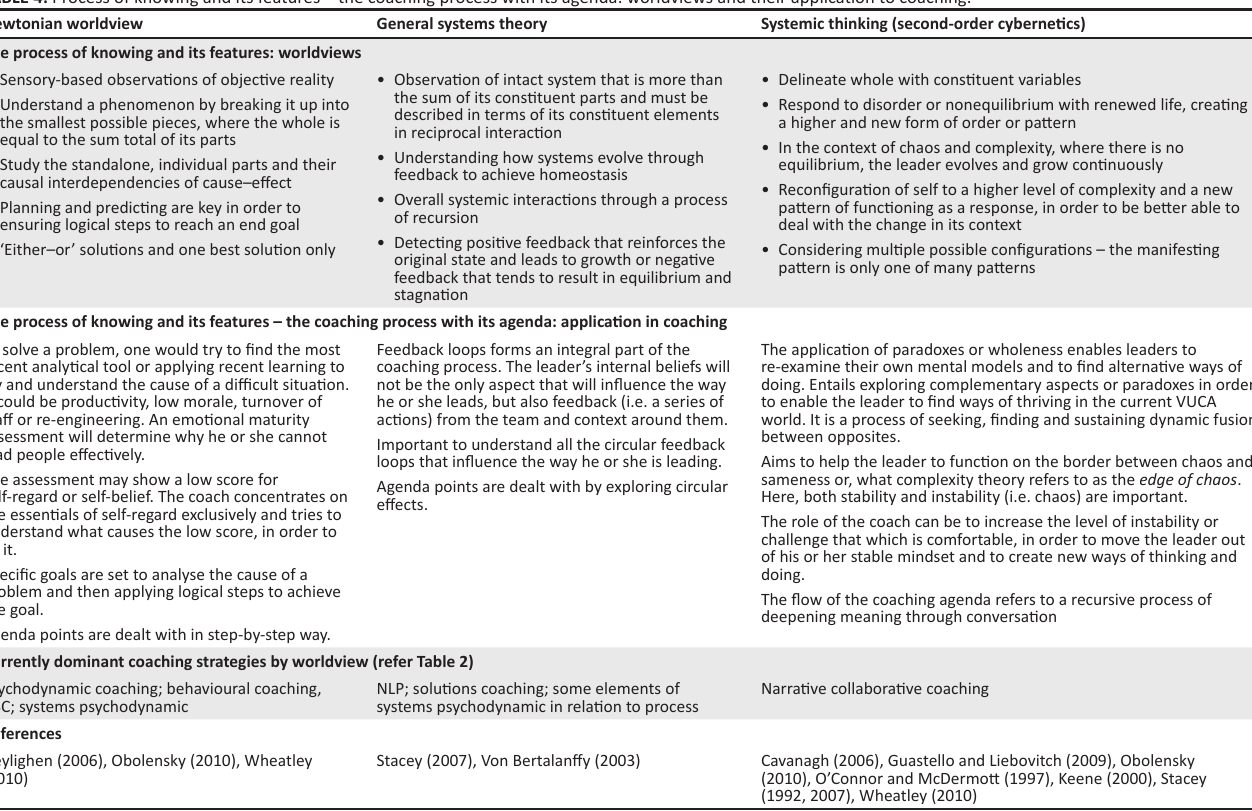
TABLE 4: Process of knowing and its features – the coaching process with its agenda: worldviews and their application to coaching. Newtonian